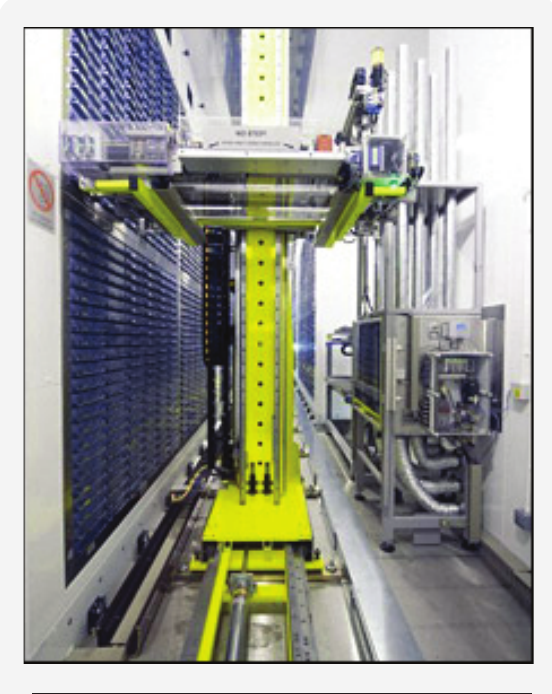
Figure 2. At a British biorepository a robot retries and returns many thousands of tissue samples from a freezer for “omics” testing. Source: The Automation